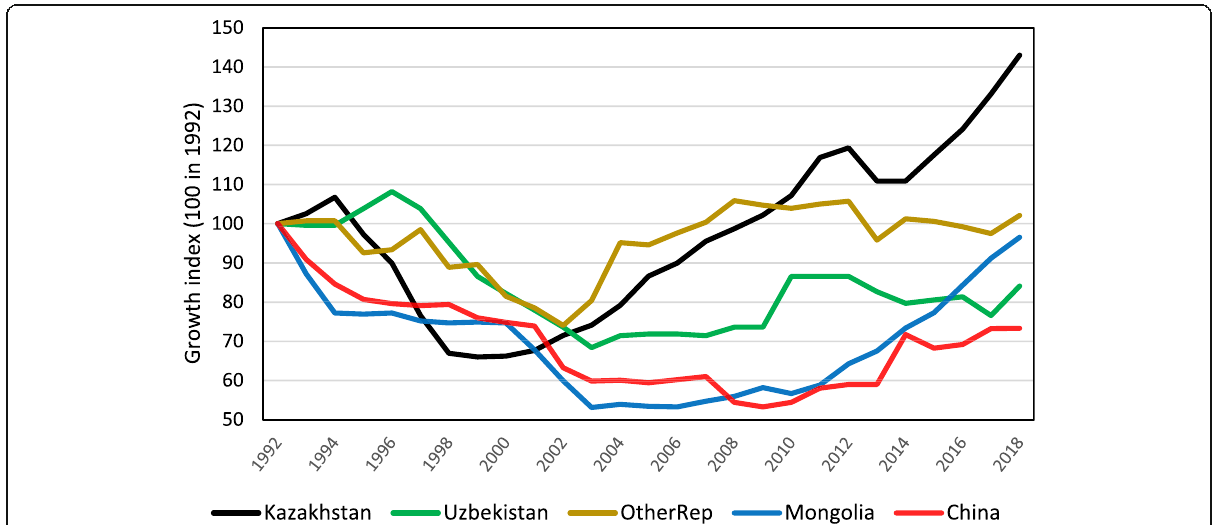
Fig. 22 Comparative demographic changes of the Bactrian camel population 1992 – 2018 in Central Asia after Soviet Union collapse (index 100 in